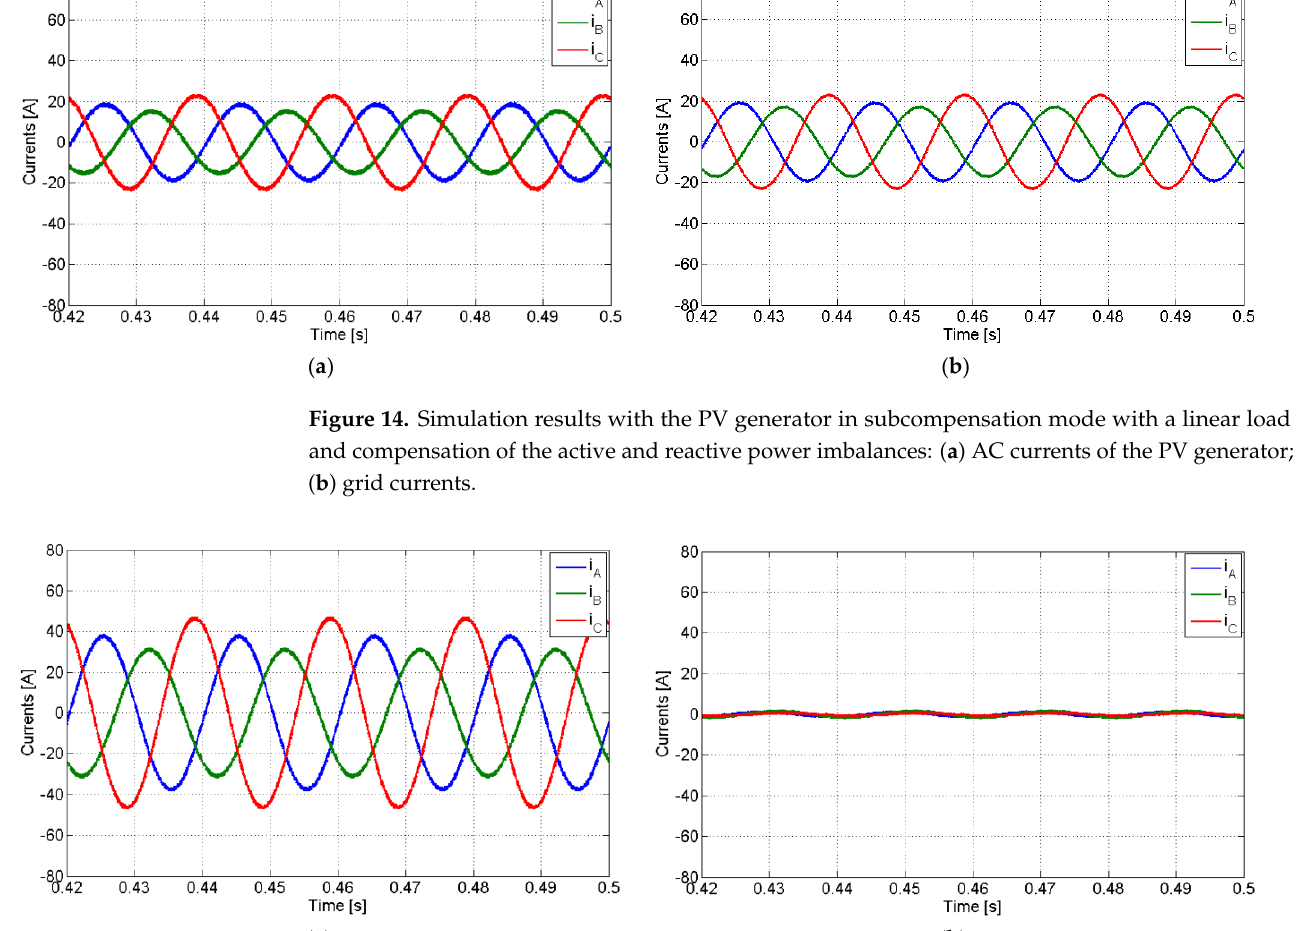
Figure 15. Simulation results with the PV generator in full compensation mode with a linear load and compensation of the active and reactive power imbalances: ( a ) AC currents of the PV generator; ( b ) grid currents.